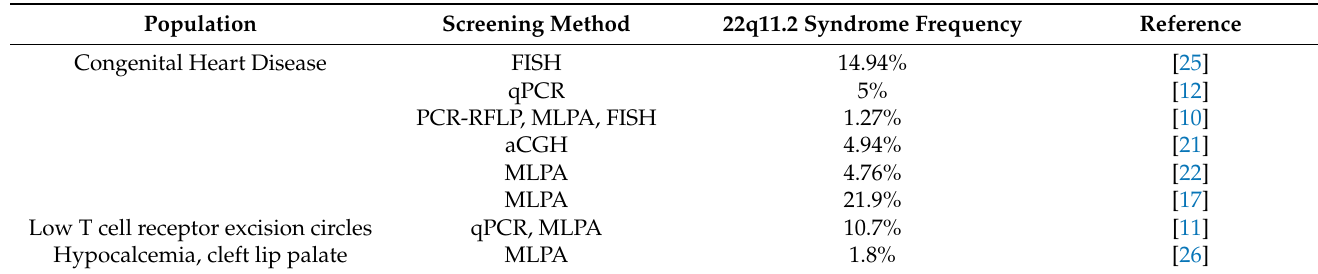
Table 1. 22q11.2 deletion syndrome in different screening